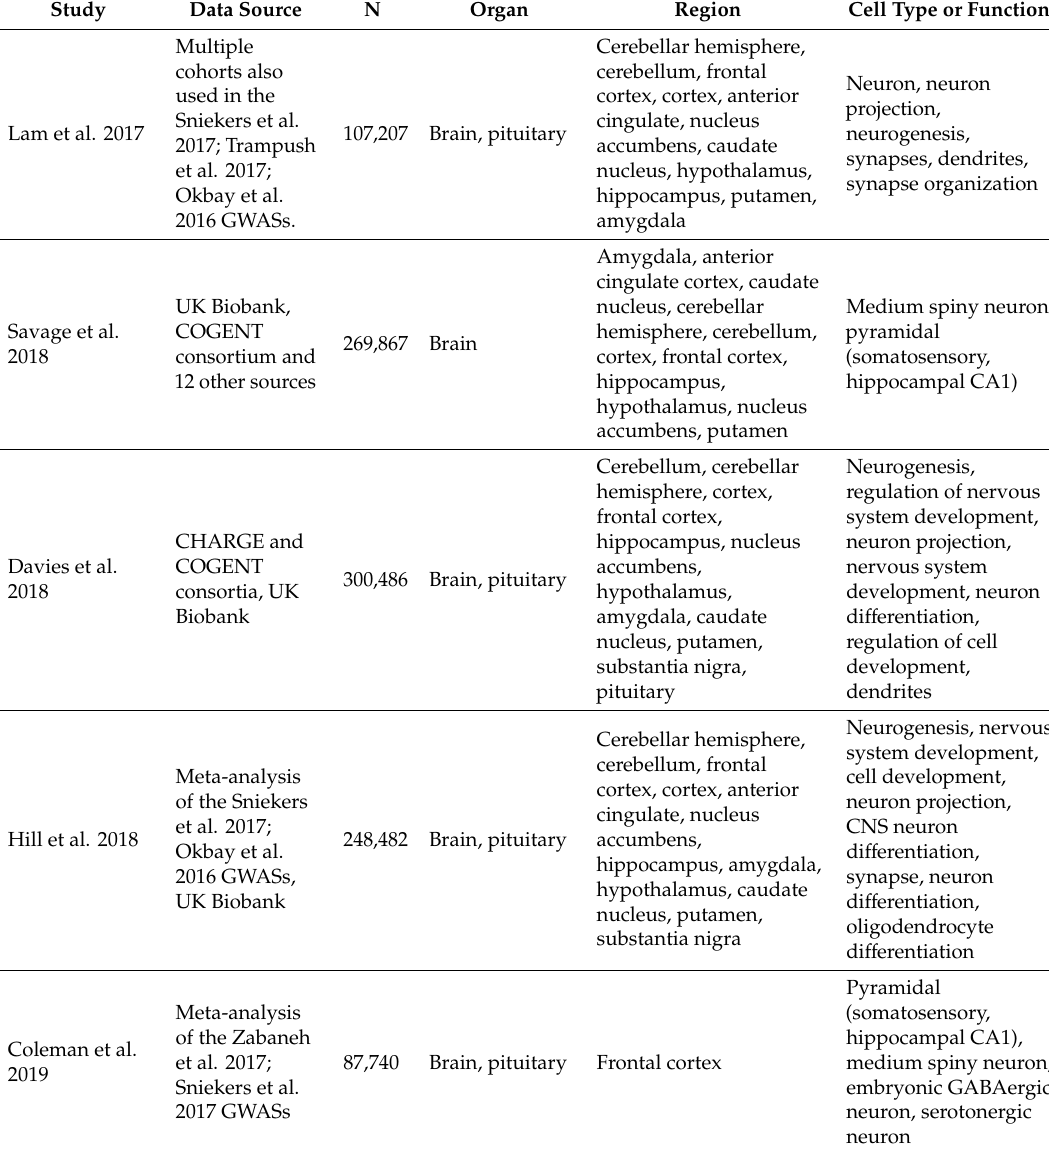
Table 1. Selected studies about the biological function of g -associated genetic variants. The last three columns highlight the organs, organ regions (typically brain regions) and cell types in which the genes mapped to g -associated single nucleotide polymorphisms (SNPs) were significantly enriched. We note that most of these studies used genetic data from multiple overlapping cohorts, hence cannot be considered